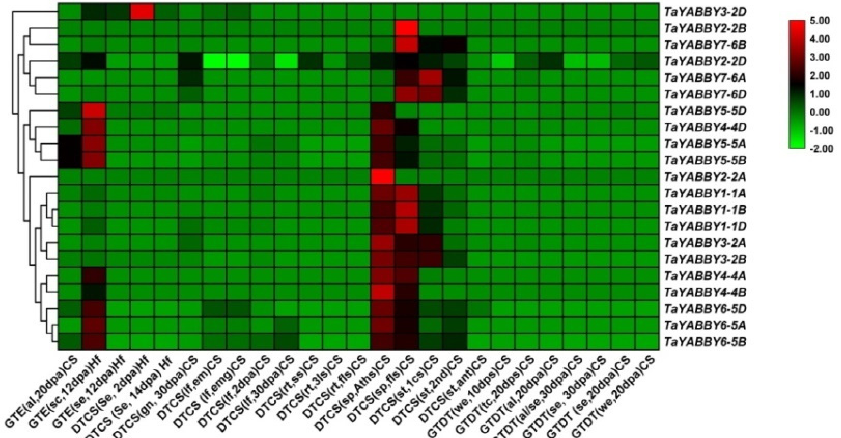
Figure 7. Heatmap of expression profiles for TaYABBY-genes in different tissue and stages. The color scale above represents expression values. Green and Red indicated the expression values increased and decreased, respectively, black indicated the expression was unregulated, GTE (Grain tissue specific expression) dpa (days post anthesis, DTC (Developmental time-course of Chinese Spring), GTDT (Grain tissue-specific developmental time-course). For further detail see supplementary sheet